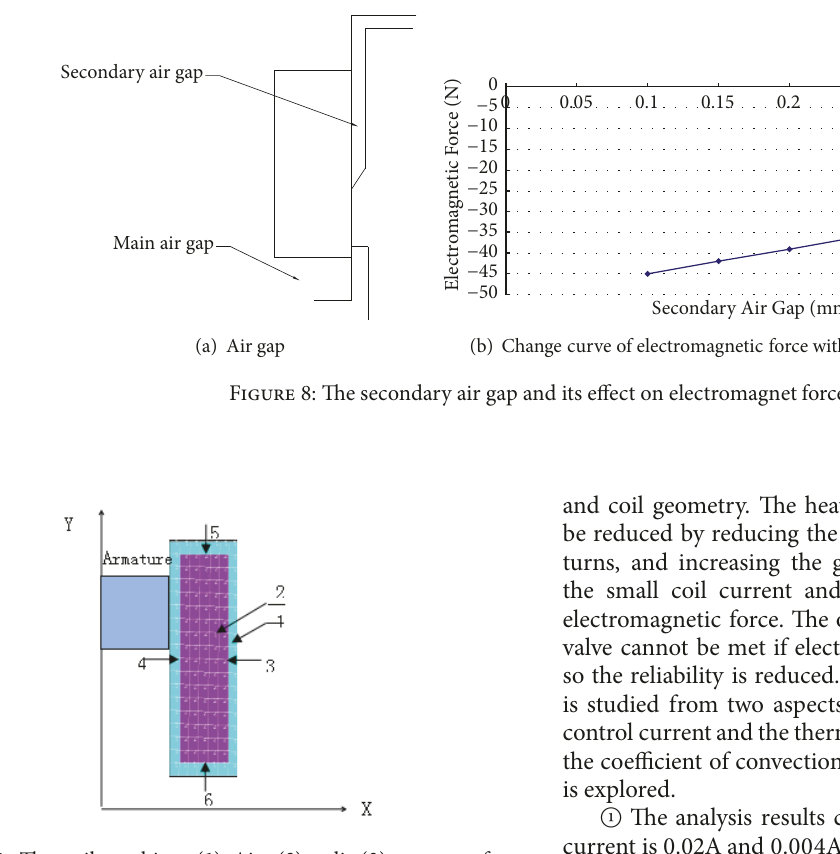
Figure 9: The coil meshing. (1) Air; (2) coli; (3) outer surface (faraway from armature); (4) inner surface (closed to armature); (5) upper surface; (6) lower